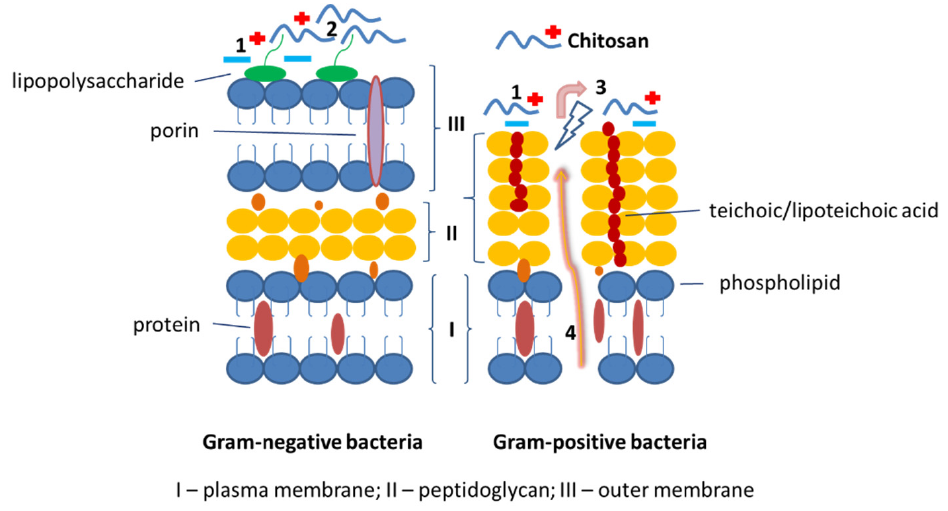
Figure 8. Schematic representation of chitosan mode of action on Gram-negative and Gram-positive bacteria cell wall. 1. Electrostatic adsorption and interaction between chitosan with cationic ions and bacteria cell wall. 2. The collapse of the outer membrane of the cell wall and blocking of nutrient flow. 3. Modification of cell permeability and disruption of the plasma membrane. 4. Osmotic damage and release of intracellular components.